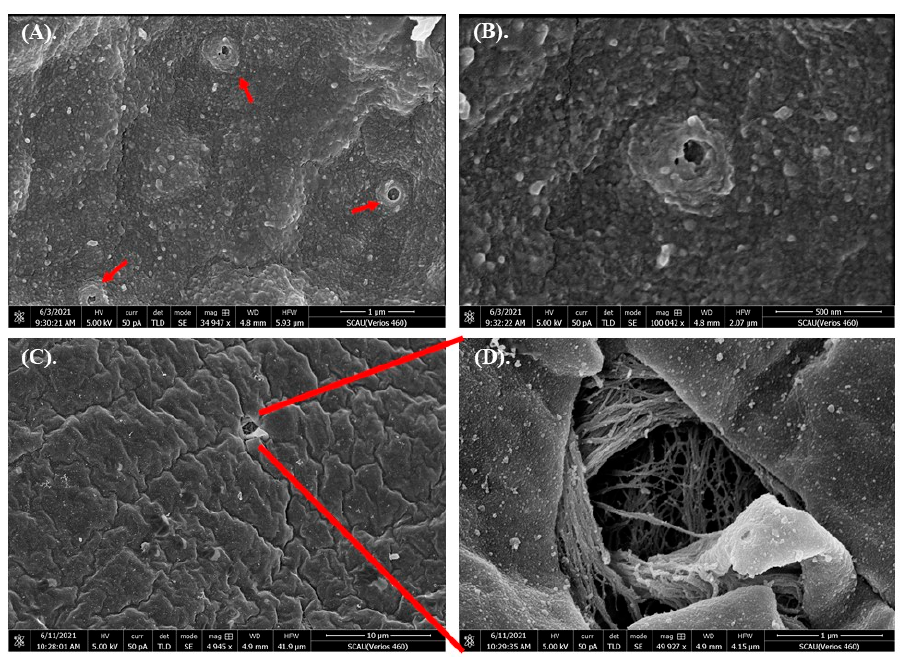
Figure 3. The pore structures of the out-membrane surface of grass carp embryo after exposed to microplastics. ( A – C ) show different pore structures. ( D ) is a larger version of ( C ).